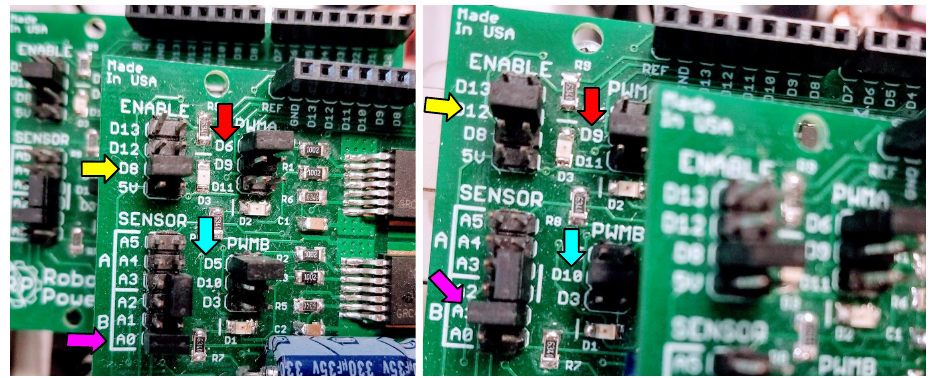
Figure 13. The jumper settings for the motor controllers. Left : The steering motor controller. ENABLE (D8), SENSOR (A0), PWMA (D6), and PWMB (D5). Right : The driving motor controller. ENABLE (D12), SENSOR (A1), PWMA (D9), and PWMB (D10).